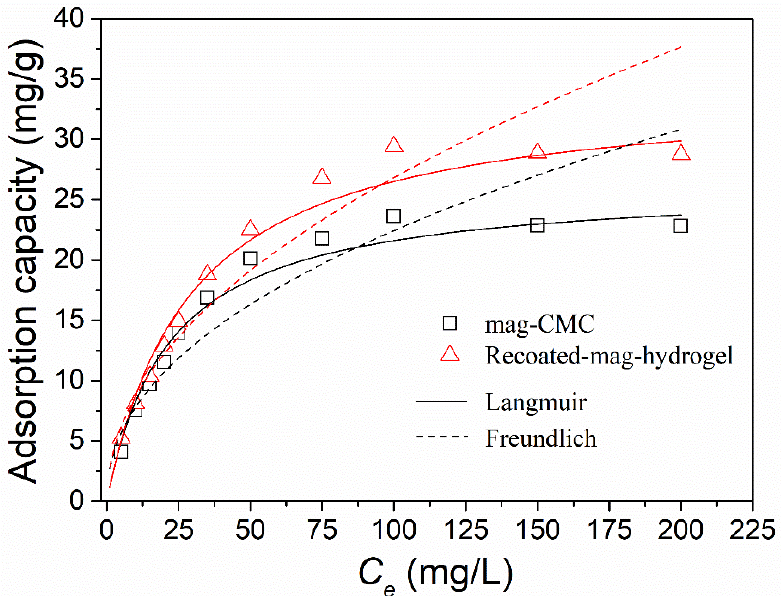
Figure 10. Effect of initial dye concentration on MB adsorption onto magnetic nanocomposites and fit curves of adsorption data by isotherm models.